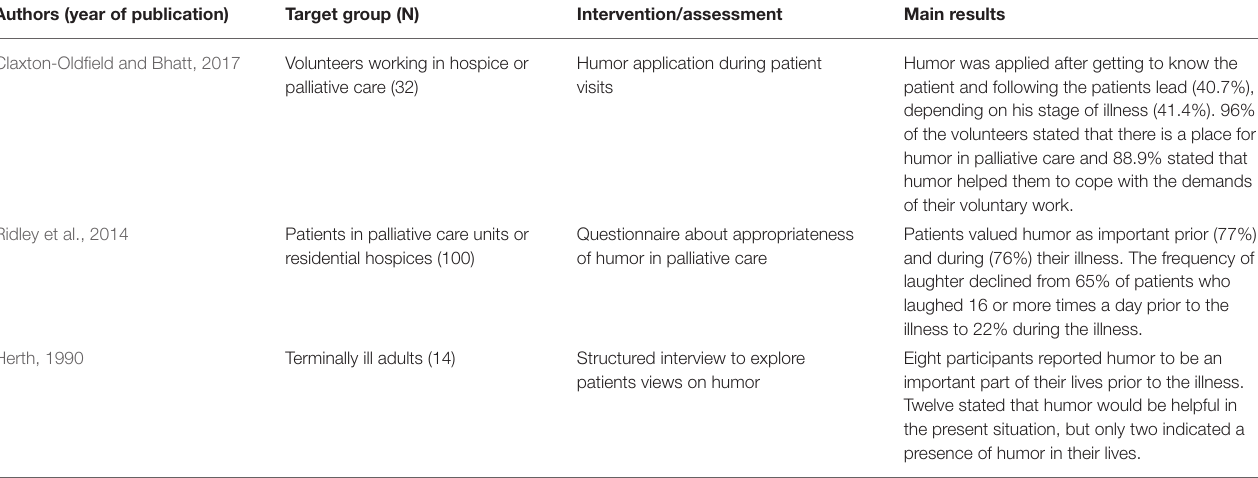
TABLE 2 | Studies exploring perceptions and appropriateness in hospice